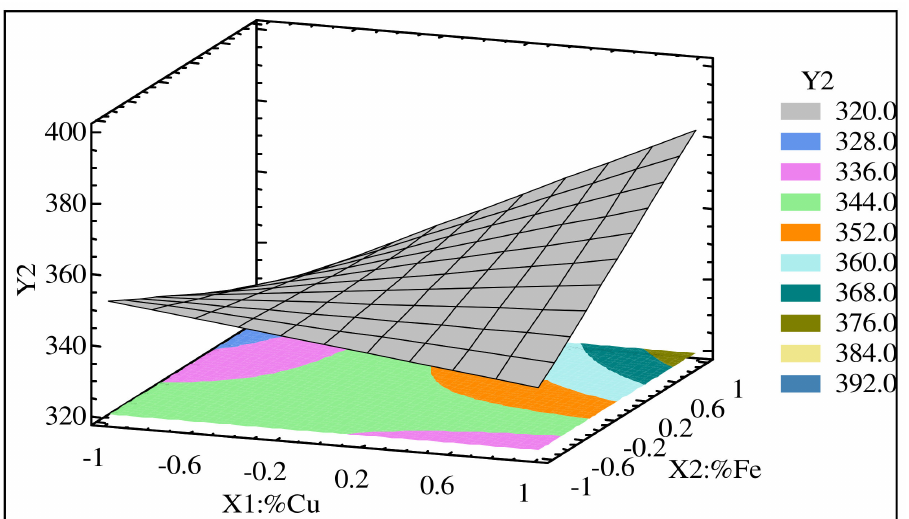
Figure 3. Regression model for yield stress (YS) as a function of Cu and Fe content in heat-treated Al-11%Si alloys containing 100 ppm